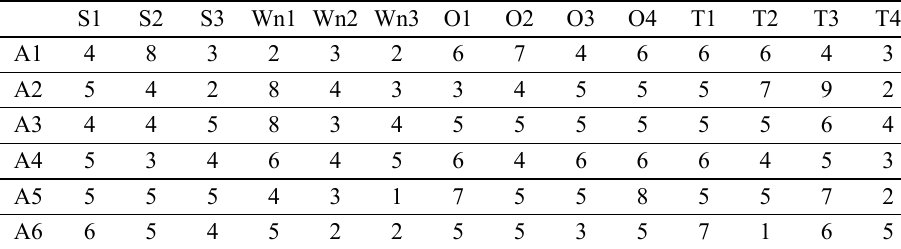
Table 9. A sample of decision matrix